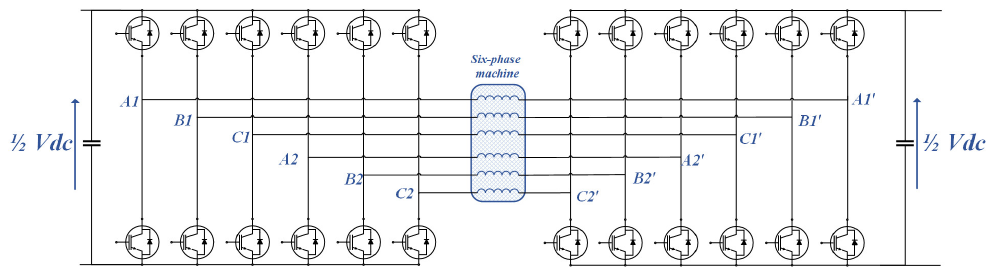
Figure 23. Open-end winding, six-phase topology with dual two-level inverters and dual dc sources (topology I).